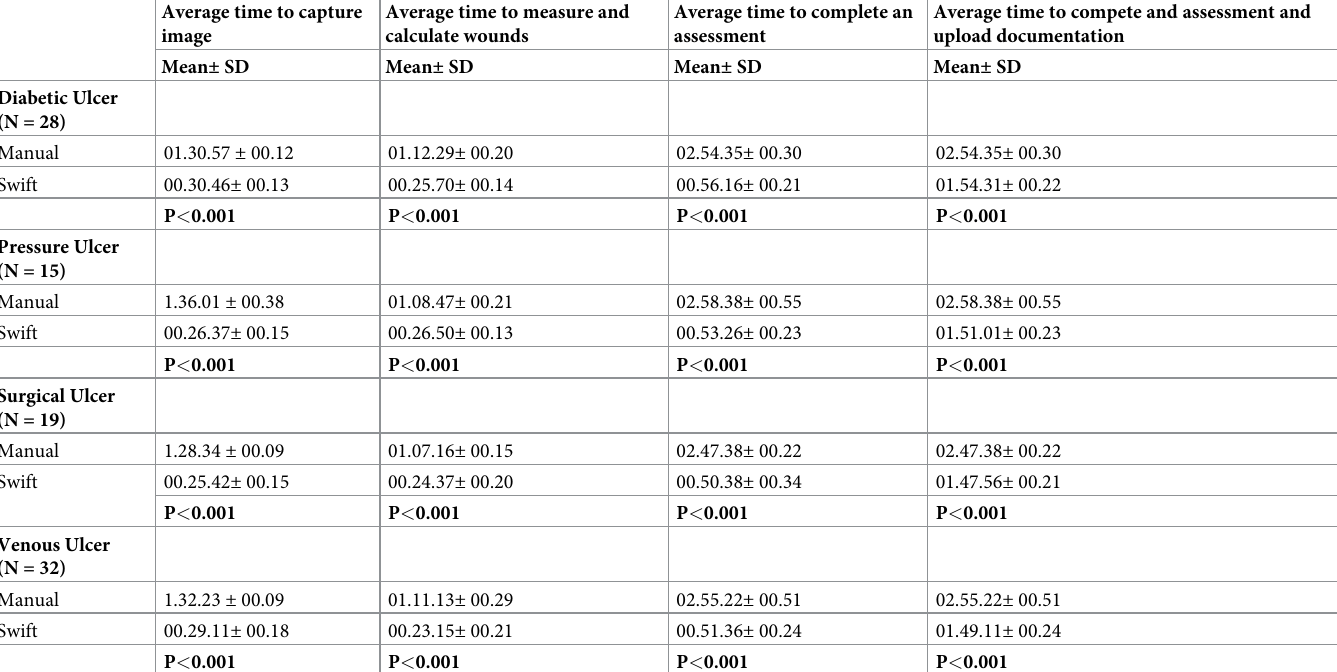
Table 3. Time to successfully complete each activity necessary to evaluate wounds using manual and Swift methods by wound